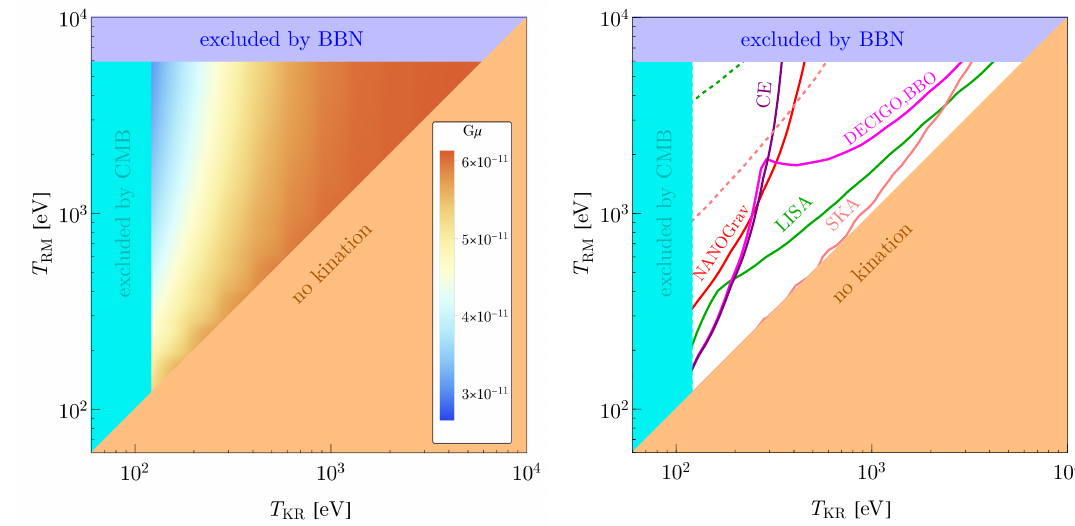
Figure 14 . Left: required Gµ for Ω GW h 2 to pass through the NANOGrav signal [41, 44, 45]. For long kination eras, which occur when T RM (cid:29) T KR , Gµ decreases with respect to the standard Λ CDM cosmology so that the kination peak does not exceed the NANOGrav signal. Right: the parameter region of axion kination whose imprints on the gravitational wave spectrum from cosmic strings can be detected. For each ( T RM , T KR ) , we fix Gµ according to the left panel so that spectrum passes through the NANOGrav signal. For the reference Λ CDM cosmology, we fix Gµ and α to 6 × 10 − 11 and 0 . 1 , respectively, to also fit NANOGrav. For a given ( T KR , T MK ) , a detection is registered when the difference in amplitudes, Ω GW − Ω GW , 0 is greater than 10% (solid) or 100% (dashed) of the standard cosmological amplitude, Ω GW , 0 , within the sensitivity curve of the